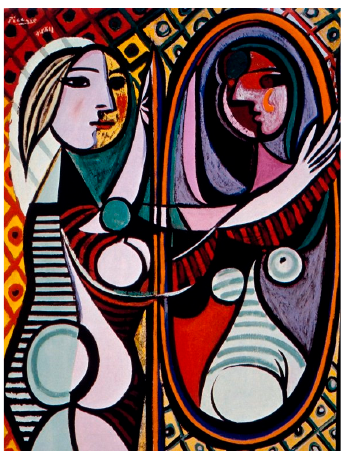
Figure 7. Pablo Picasso, Girl before a Mirror , Boisgeloup, March 1932, oil on canvas, 64 × 51 1/4 in. (162.3 × 130.2 cm). Collection Museum of Modern Art. New York. Gift of Mrs. Simon Guggenheim. © 2022 Estate of Pablo Picasso/Artists Rights Society (ARS), New York.